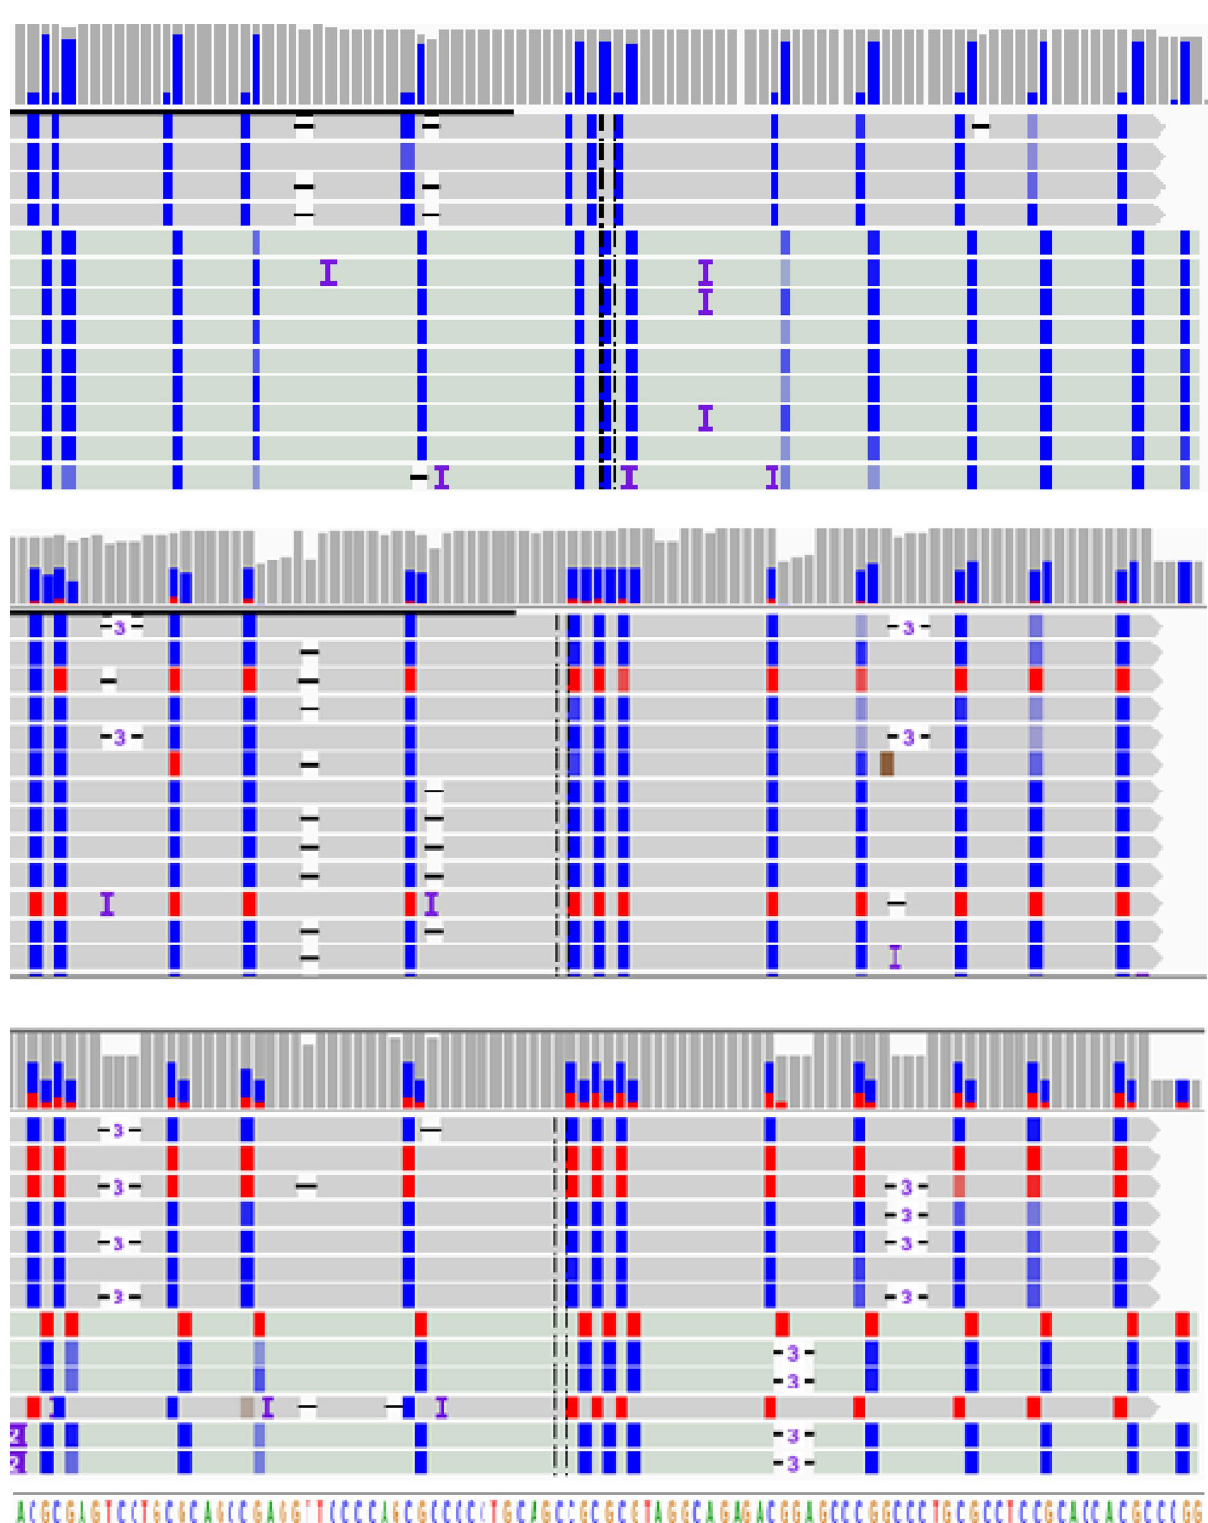
Figure 8. Methylation of a fragment of the ITGA4 gene promoter assessed by reduced representation bisulfite sequencing (XmaI-RRBS). Each track represents a sequence (read) of a single molecule from the sample. A fragment of 96 base pairs is presented, sequenced in a normal breast tissue sample (upper panel) and in two different HER2 positive breast cancer samples (two lower panels). Red is for methylated cytosines and blue is for nonmethylated cytosines in the CpG context. Reference genome sequence is at the bottom. Symbols “-” and “-3-” seen within the reads reflect spurious single nucleotide and trinucleotide deletions, correspondingly, that arise as technical errors in detecting the lengths of homopolynucleotide tracts (poly-T and poly-A) arising as a result of bisulfite DNA